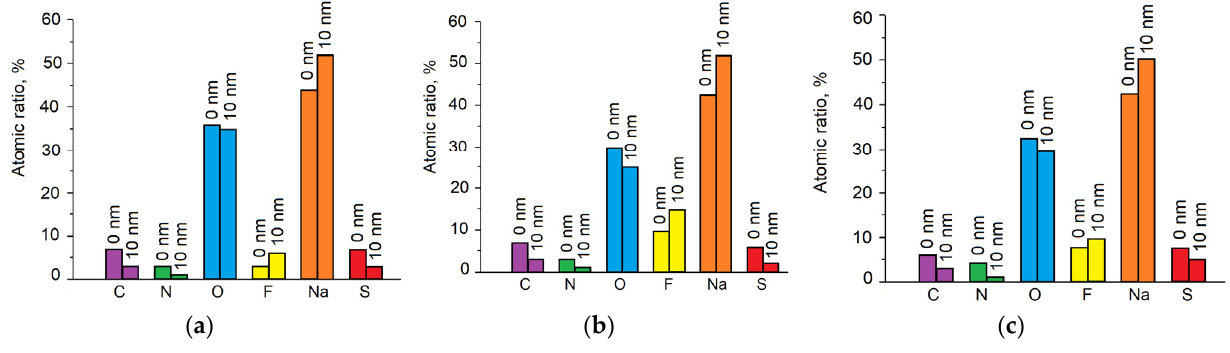
Figure 2. Depth variation in the composition of SEIs formed in different electrolytes. Electrolyte composition: ( a )—1.7 M NaFSI in DME, ( b )—5.2 M NaFSI in DME, ( c )—2.1 M NaFSI in DME:BTFE (1:2).chematic of SEI functioning.